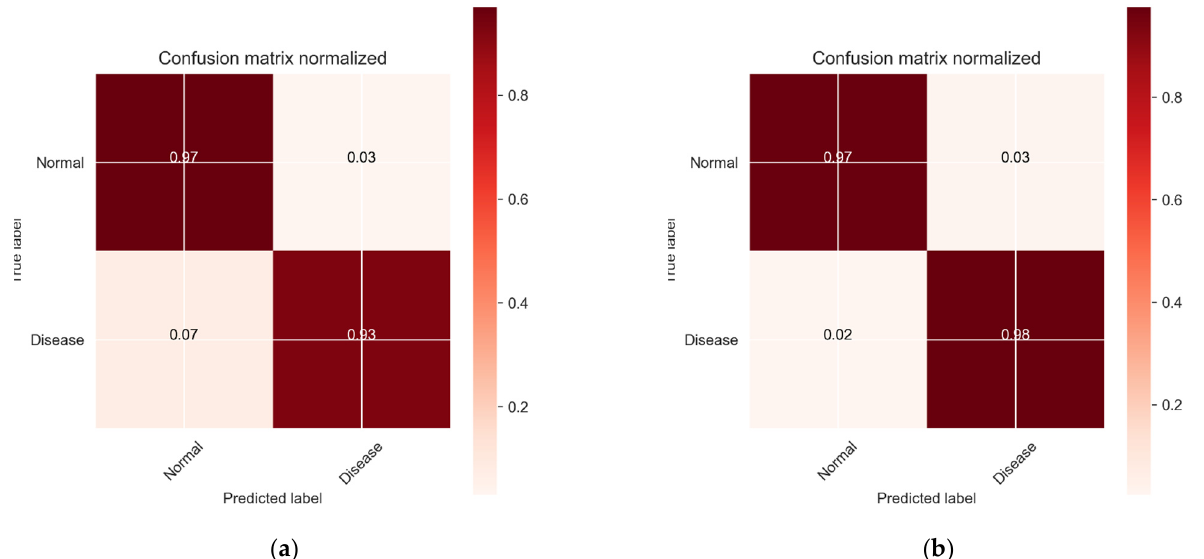
Figure 7. Confusion matrix of best model after hyper-parameter optimization: ( a ) best CNN model, ( b ) best ANN model.